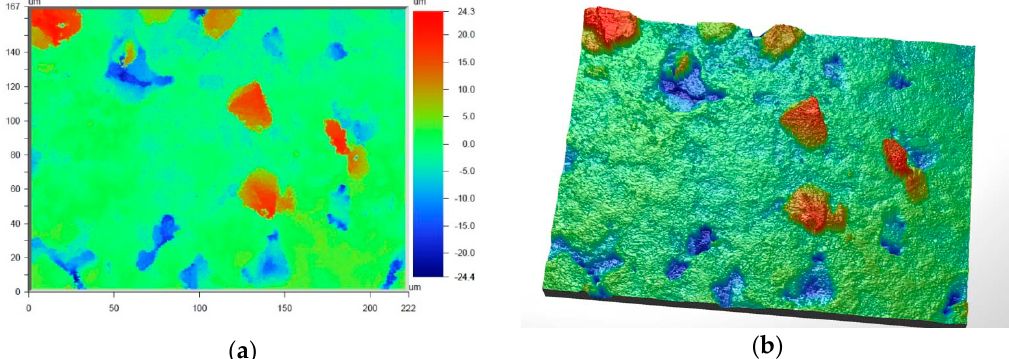
Figure 10. 2D ( a ) and 3D ( b ) profilographs of PW1 sample at a magnification of ×28.4.